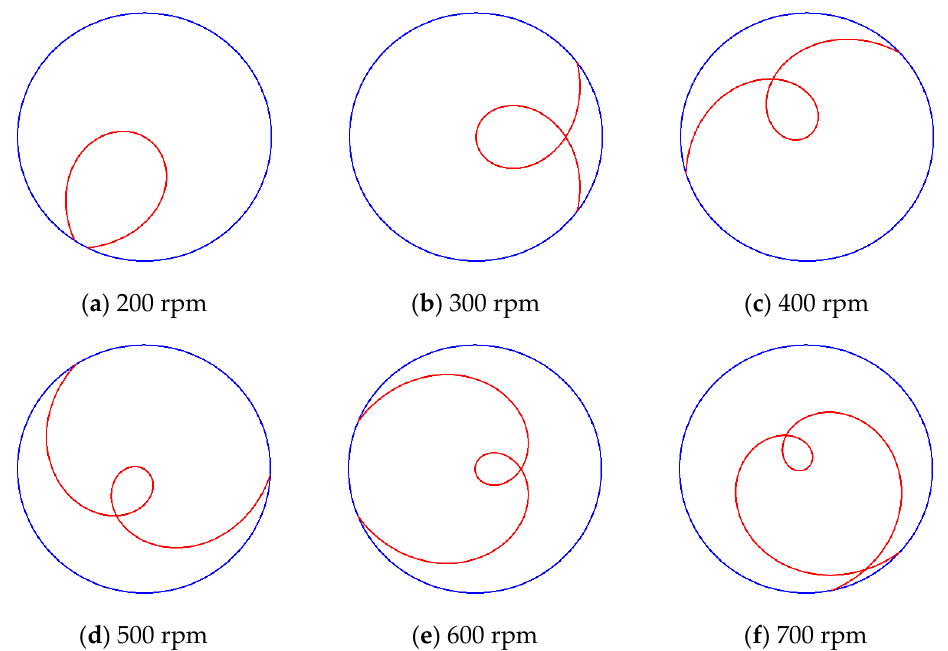
Figure 16. Motion trajectory of agglomerated particles with different workpiece speeds .